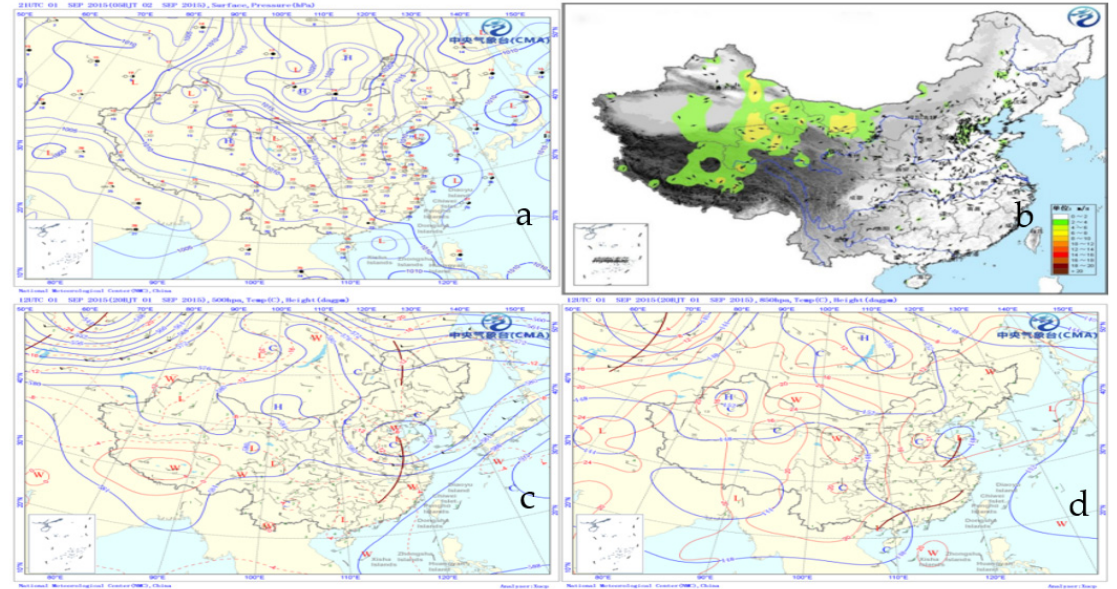
Figure 3. Maps of the weather and AQI situation at 07:00 on 1 September in 2015. Notes: ( a , c , d ) shows the map of the surface, 500 hPa height, 850 hPa height, respectively. ( b ) shows the automatic ground observation of 1 h wind field at 07:00 on 1 September in